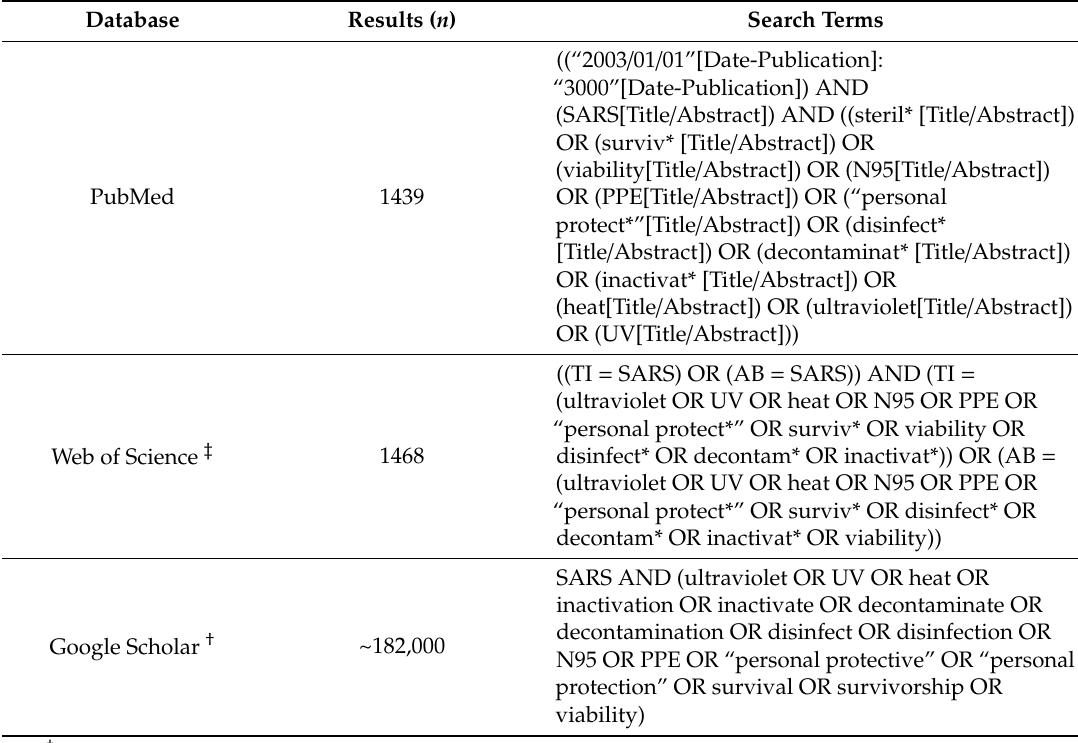
Table 1. Databases / search engines used for this review, including combinations of keywords and Boolean operators, and number of results yielded as of 18 July